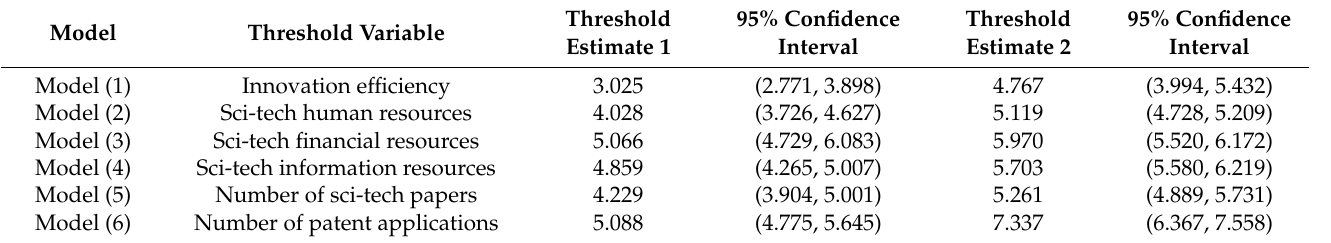
Table 5. Double-threshold estimates of innovative cities.